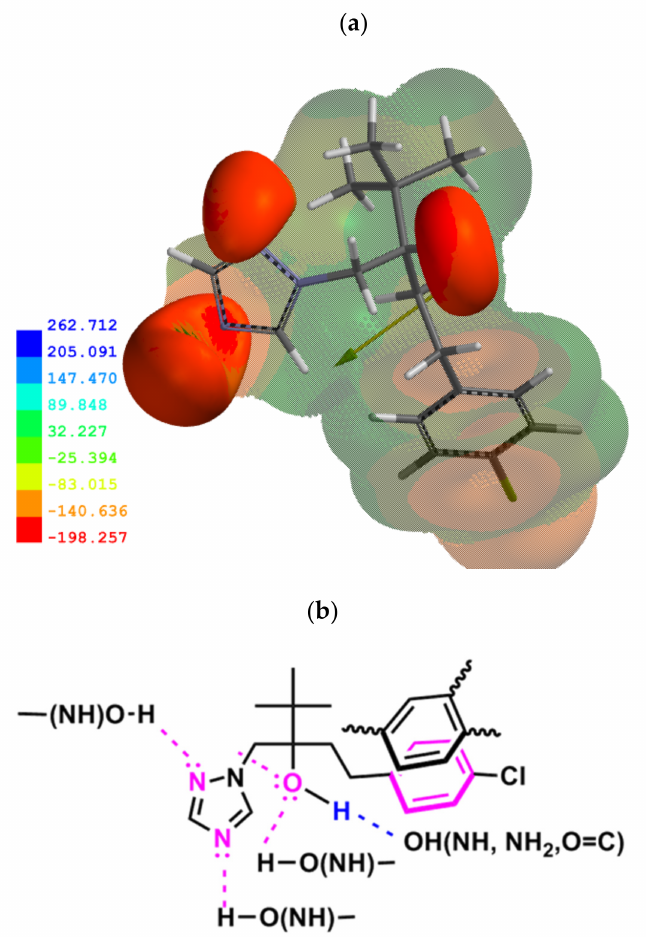
Figure 3. ( a ) Molecular electrostatic potential density (the superimposed electrostatic potential profile at − 83.7 kJ/mol) and the dipole moment of TB; the deepest blue color—the most positive potential, the deepest red green—the most negative potential, the intermediate shades—the intermediate potential regions. ( b ) The proposed network of hydrogen bonds and π – π interactions between TB and